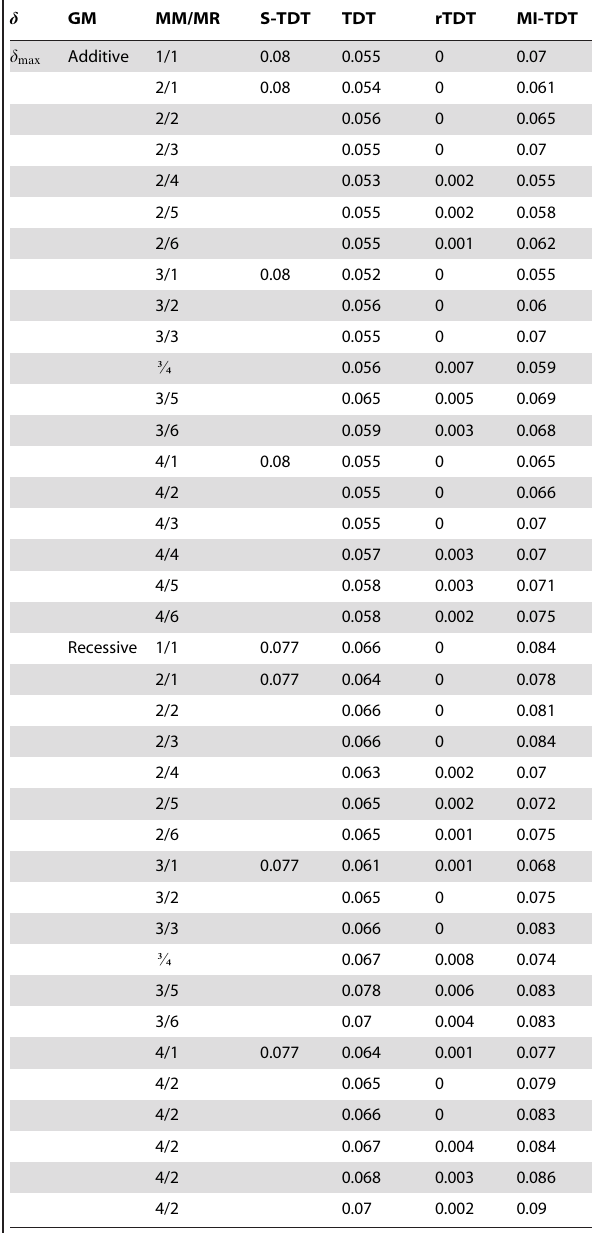
Table 15. Power analysis continues. Table 16. Type I Diabetes (IDDM): The significant SNPs for complete data.